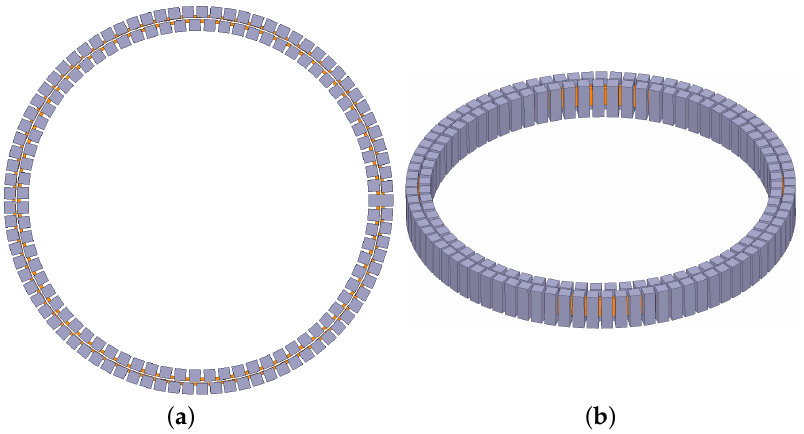
Figure 9. Electromagnetic model of the rotary transformer with C-shaped ferrites forming the cores: ( a ) top and ( b ) perspective views of the complete 3D model.